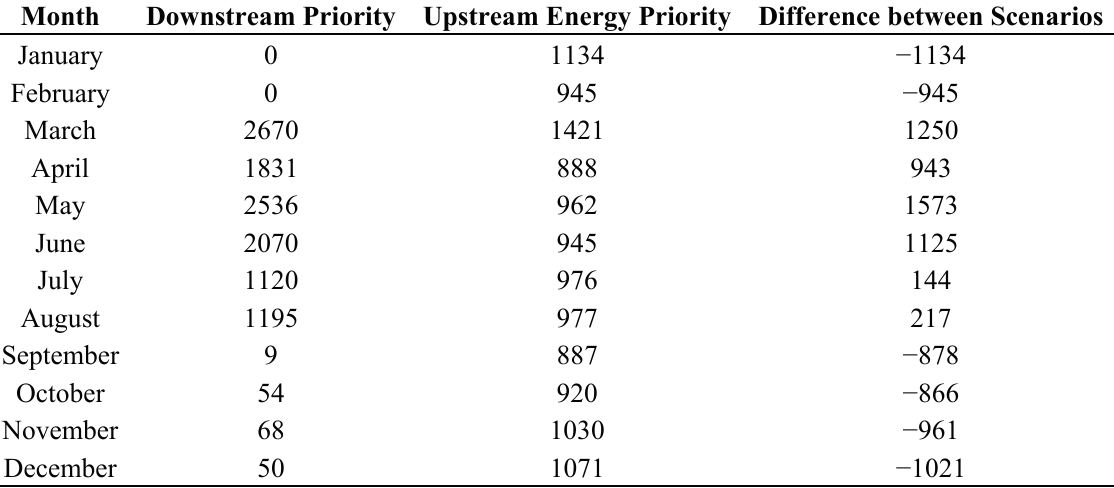
Table 4. Rogun reservoir energy production in two scenarios by months, averaged over future years (GW